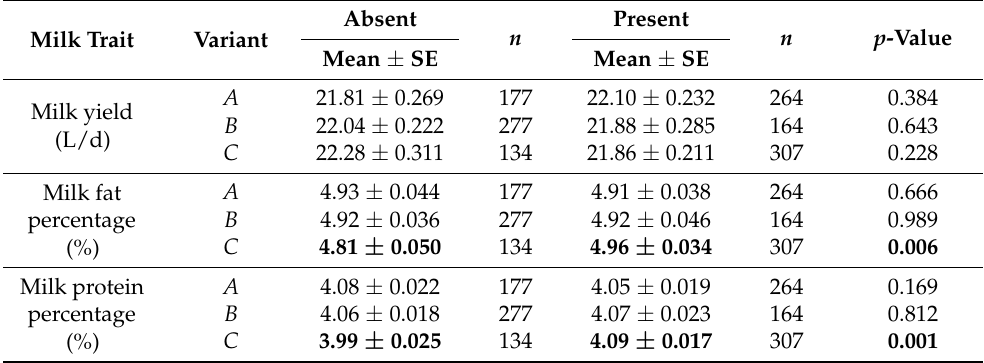
Table 2. Association between the presence or absence of individual variants in the LPIN1 sixth coding exon and milk traits 1 .